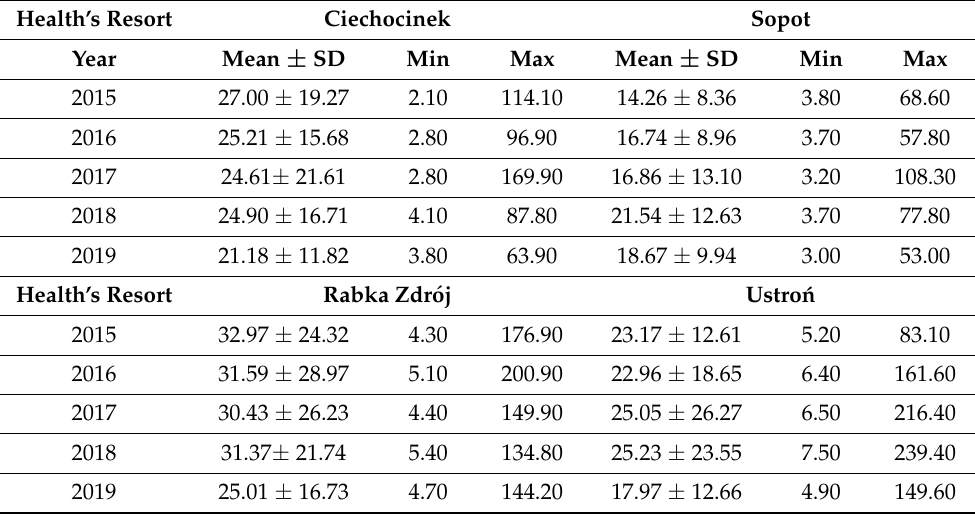
Table 2. Average annual values of PM 10 in the studied health resorts in 2015–2019. Health’s Resort Ciechocinek